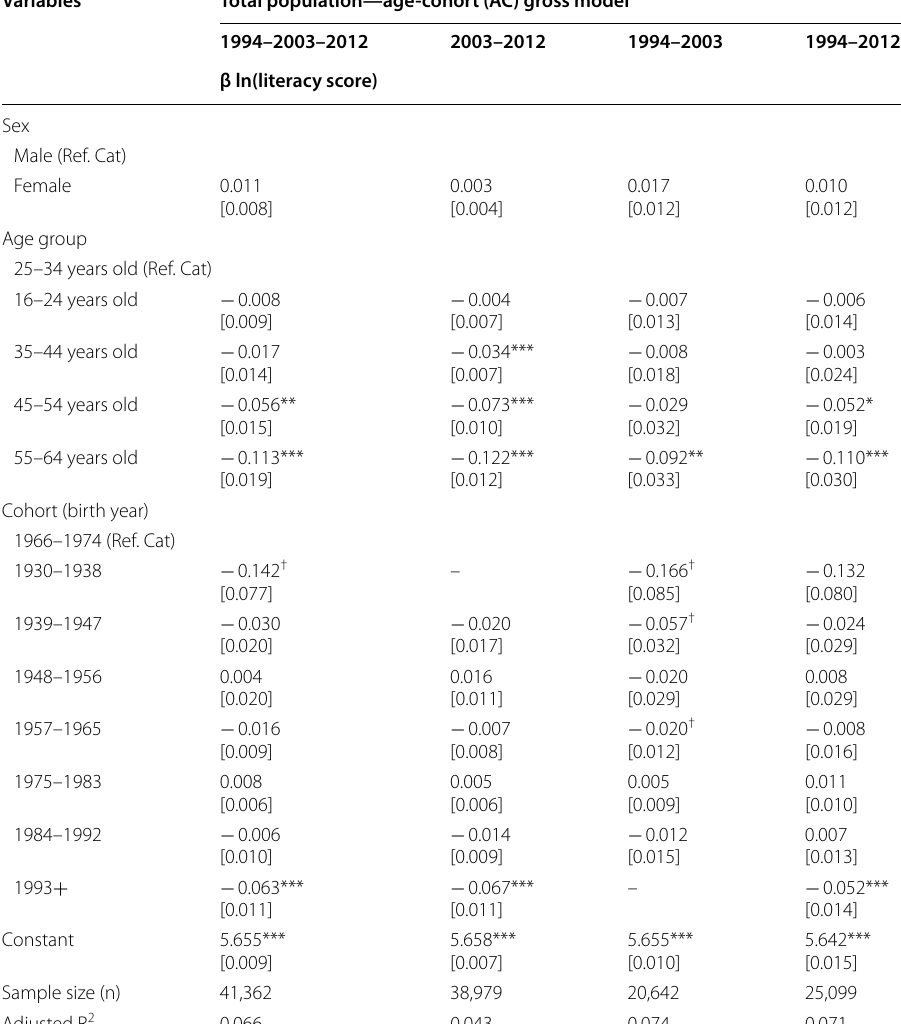
Table 4 Weighted linear regression of the natural logarithm of the literacy score, Canada, 1994 IALS, 2003 ALL and 2012 PIAAC data combined (Gross model—”Gross” cohort effect (with sex and